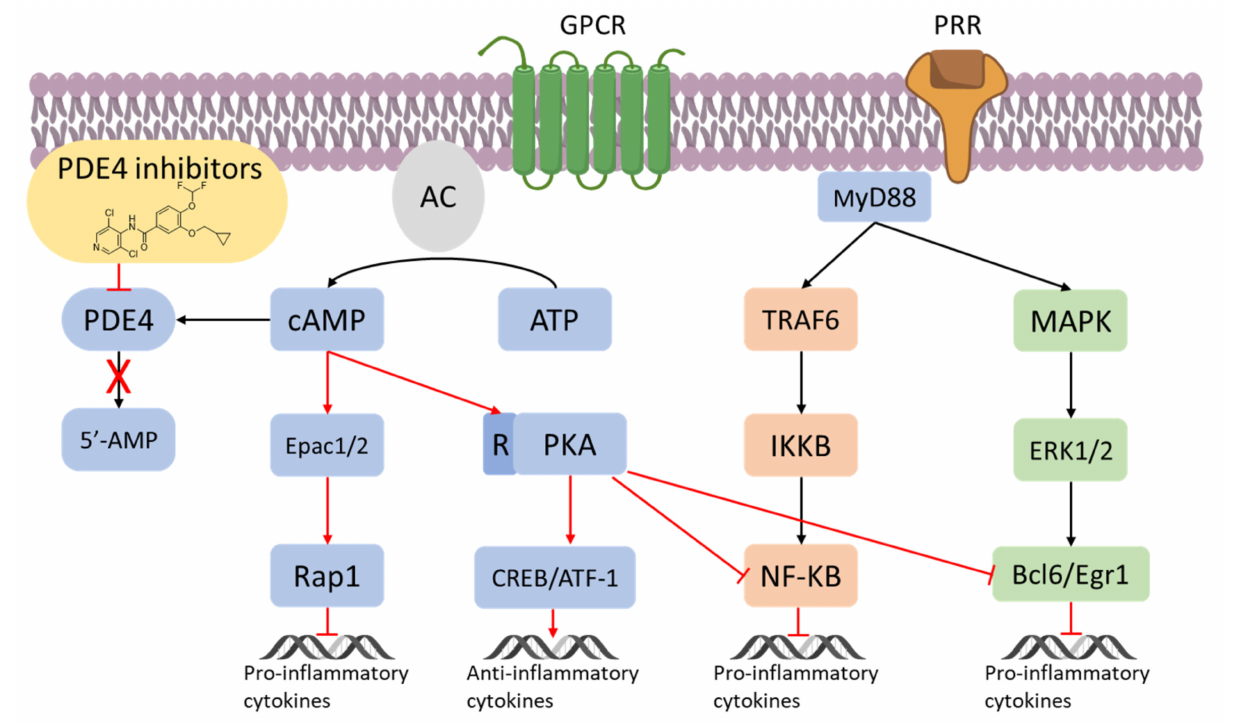
Figure 3. PDE4 inhibitors in the regulation of inflammatory responses